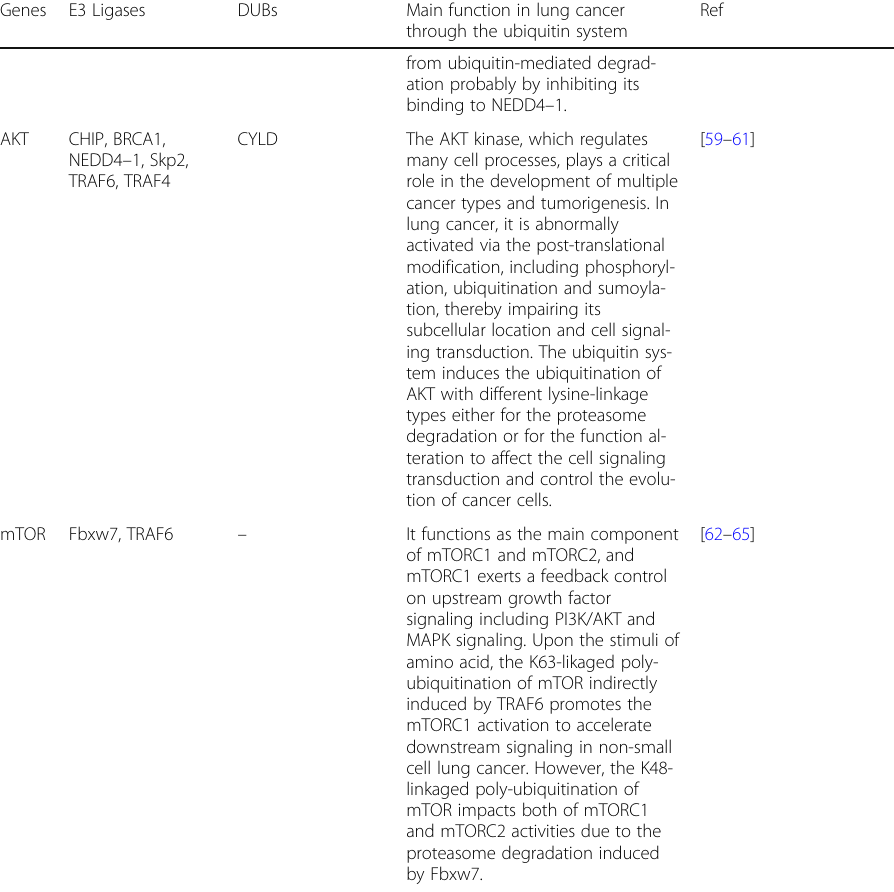
Table 1 A list of ubiquitin E3 ligases and deubiquitination enzymes that have been found in regulation of associated genes in NSCLC (Continued) Genes E3 Ligases DUBs Main function in lung cancer